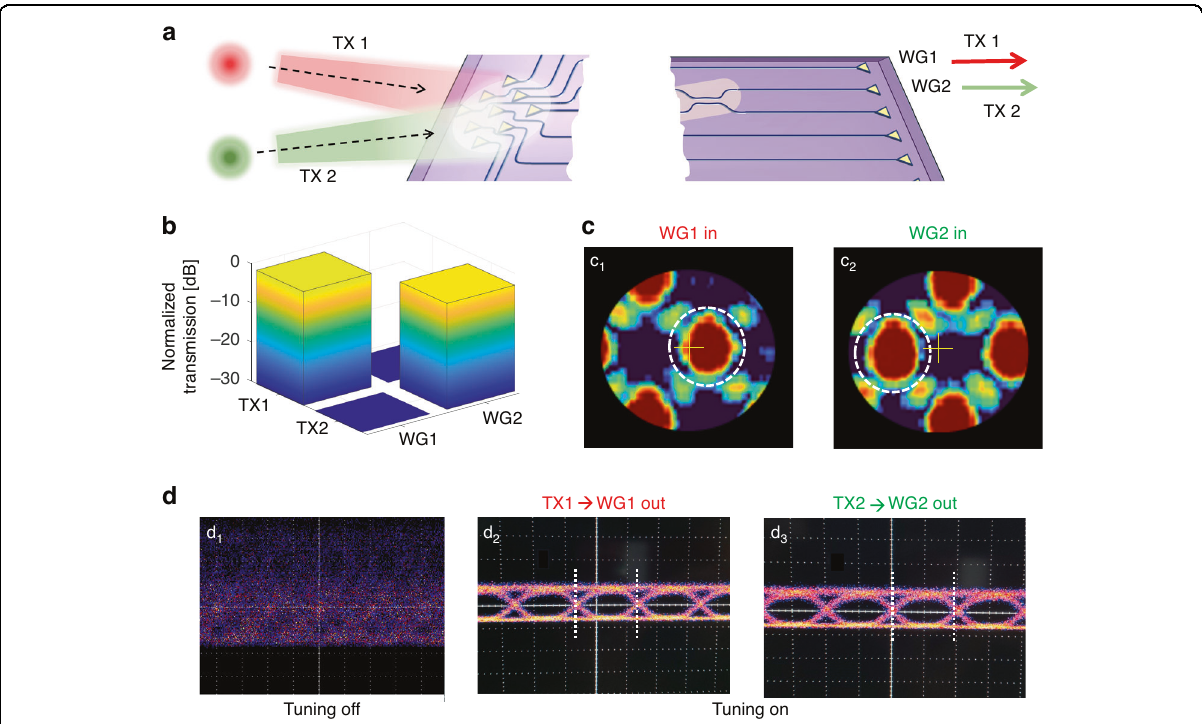
Fig. 2 Direction-diversity receiver. a Schematic representation of two free-space beams (TX1 and TX2), sharing the same wavelength and state of polarization, and arriving at the receiver from different directions. b Bar chart showing the normalized insertion loss of the beams TX1 and TX2 (relative angle 1.25°) at the output waveguides WG1 and WG2. c Backward far- fi eld intensity pattern radiated by the 2D optical antenna array when the photonic processor is con fi gured to couple beam TX1,2 to WG1,2 launching the light from WG1 (c 1 ) and WG2 (c 2 ). d Measured eye diagrams of two received intensity modulated 10 Gbit/s OOK signals transmitted by using the two beams TX1 and TX2: (d 1 ) when the photonic processor is not con fi gured, the eye diagrams of TX1 and TX2 at port WG1 are severely overlapped; while after the con fi guration of the photonic processor both eyes, TX1 at port WG1 (d 2 ) and TX2 at port WG2 (d 3 ) are clearly open with neither evident distortion nor inter-symbol